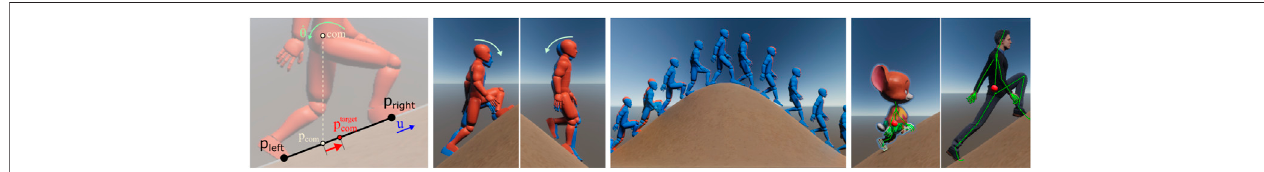
FIGURE 1 | Adaptive character locomotion on non- fl at terrains. Left: the torque magnitude depends on the distance between the middle of the support polygon p target com and the projection of the character ’ s center of mass p com on the terrain, as well as on the current angular velocity _ θ . Middle: comparison between characters without (red) and with (blue) our torque-based controller. The blue character exhibits an increased swinging motion, which dynamically tilts it forward or backward, depending on theslope.Right: thecontrollerisrobustto changes ofcharacter morphologyas theoscillating motion automatically adapts when the center ofmass (red sphere) is positioned closer to or further from the ground.